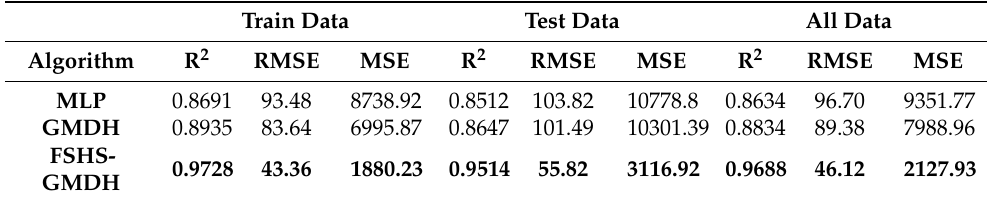
Table 3. Statistical analysis of shear wave velocity estimation calculated by ML